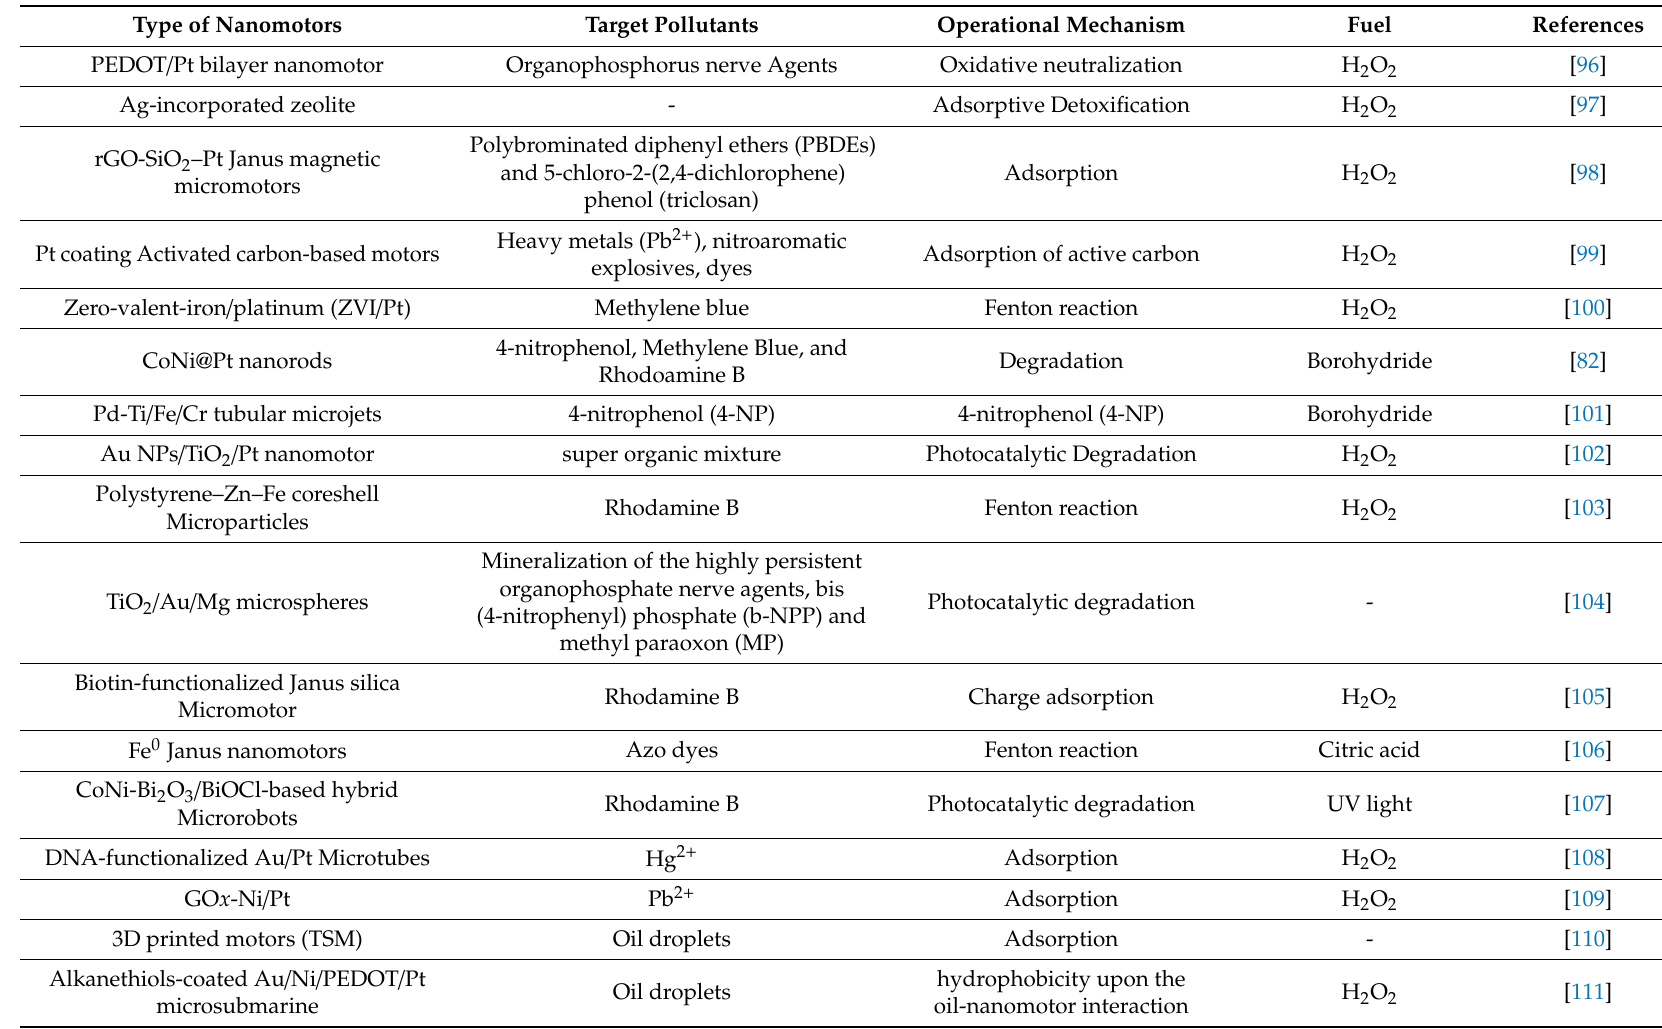
Table 3. List of nano / micromotors for water decontamination in presence of